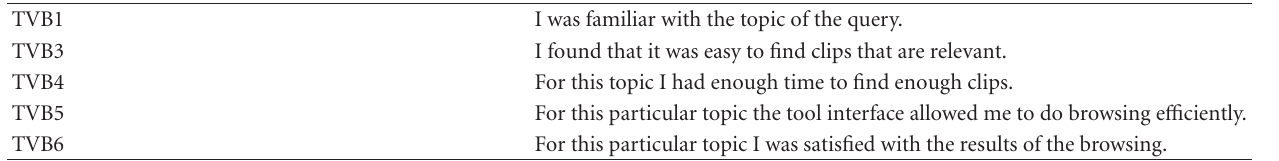
Table 1: Questions of the post-task questionnaire. Possible answers for each of the questions are: not at all, a little, fairly, quite a bit, very